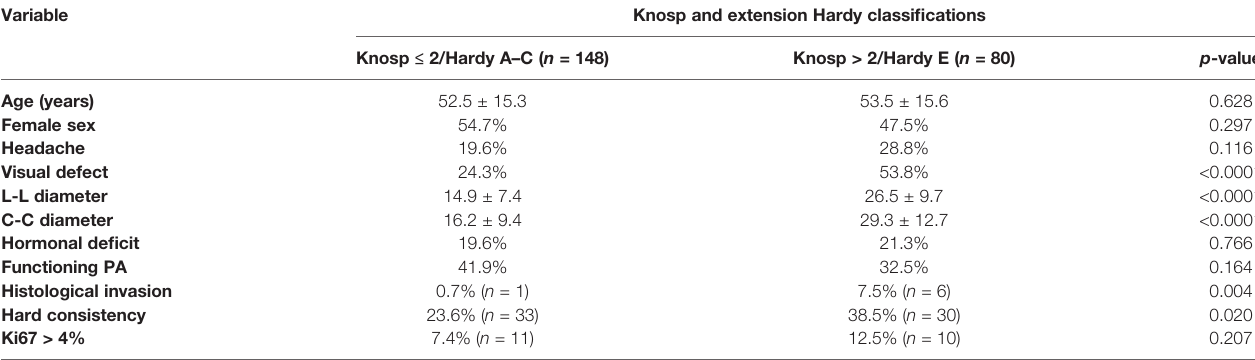
TABLE 2 | Differences in clinical, hormonal, radiological, and histological features of invasive and non-invasive pituitary adenomas. Variable